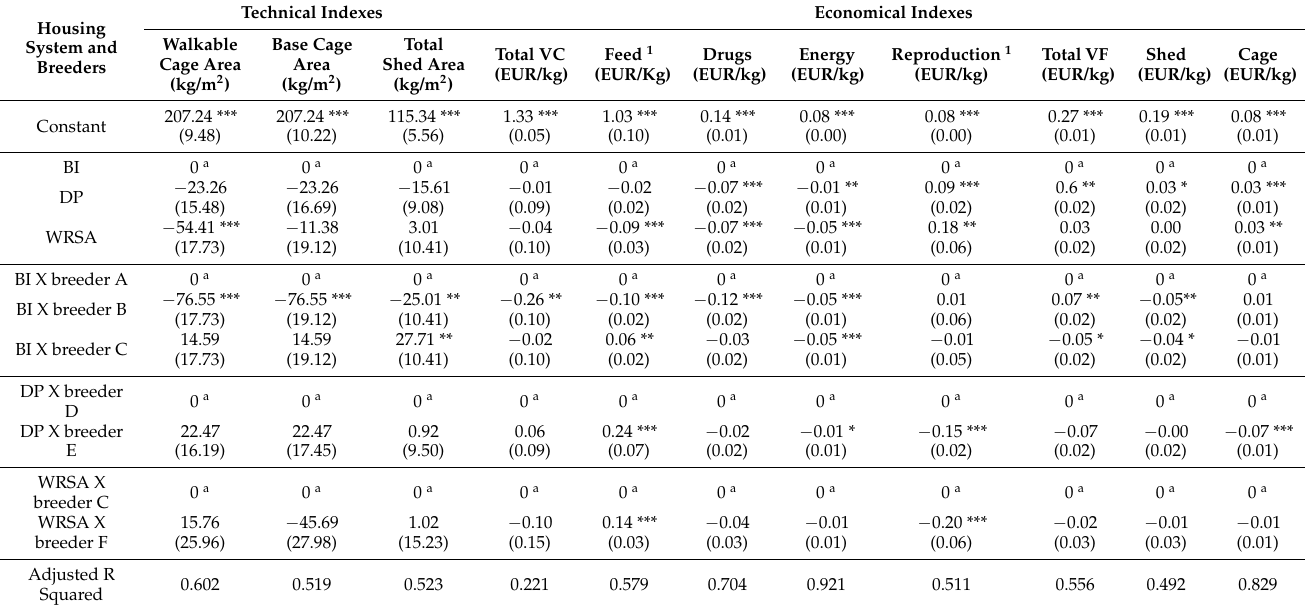
Table 4. Estimates of the effects of the housing system and the farmers within housing system in the surveyed farms (SD in